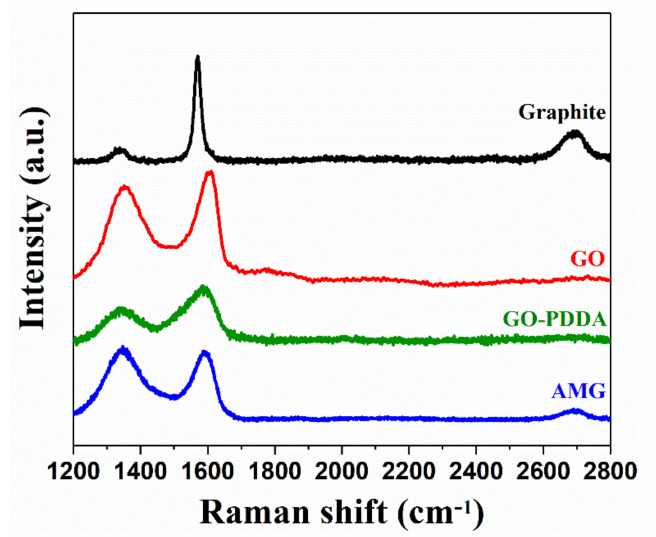
Figure 2. Raman spectroscopy analysis of graphite, GO, GO-PDDA, and AMG.